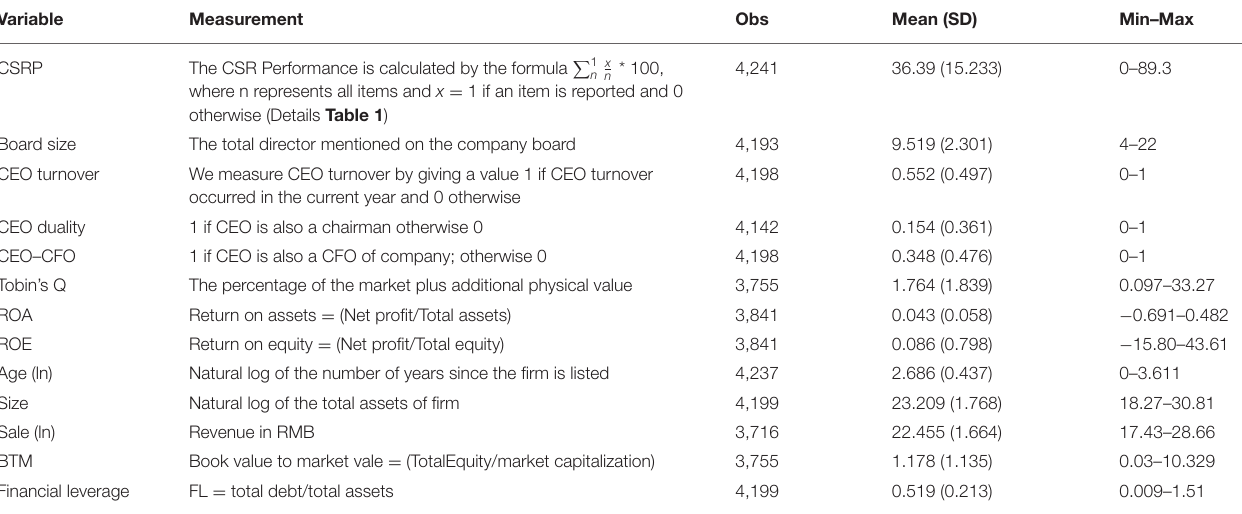
TABLE 2 | Variable measurement and descriptive